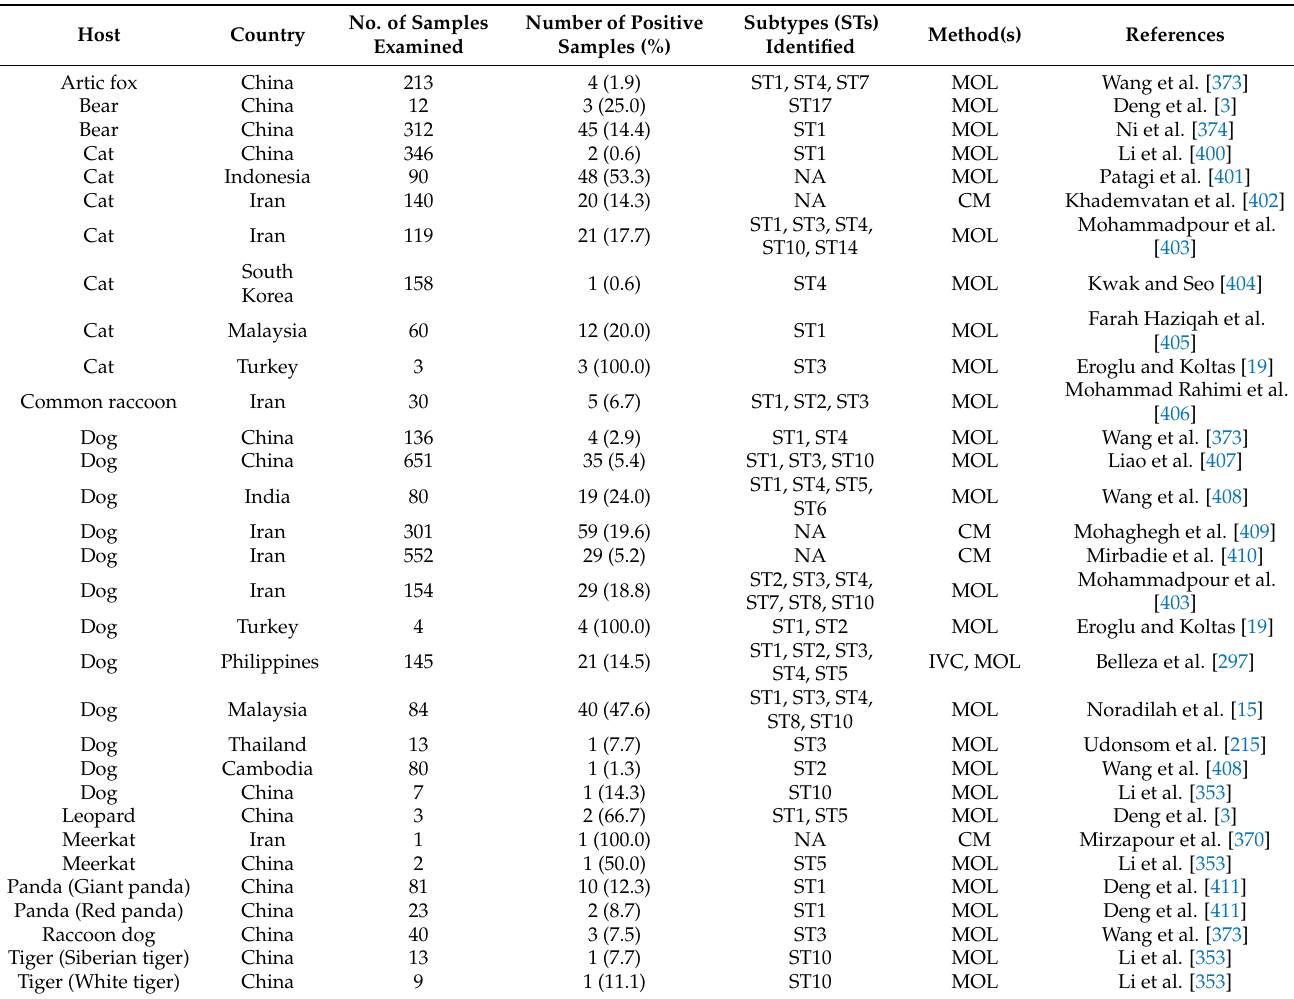
Table 10. Prevalence and subtype distribution of Blastocystis spp. in carnivorous animals in Asia